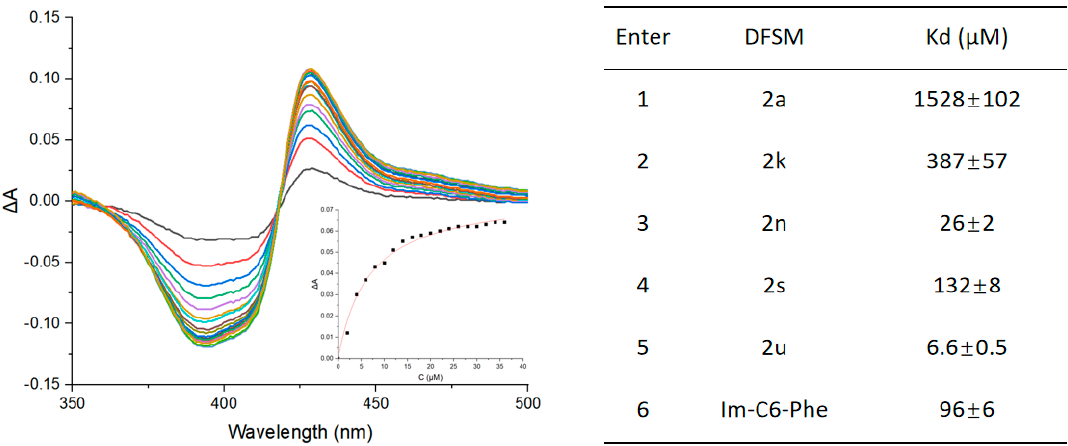
Figure 5. The UV-vis spectral change of F87A upon the addition of 2u (left), and the dissociation constants estimated by the titration experiment (inset). The dissociation constants of six representative DFSMs are summarized in the right table. The difference spectra were colored differently for clarity.